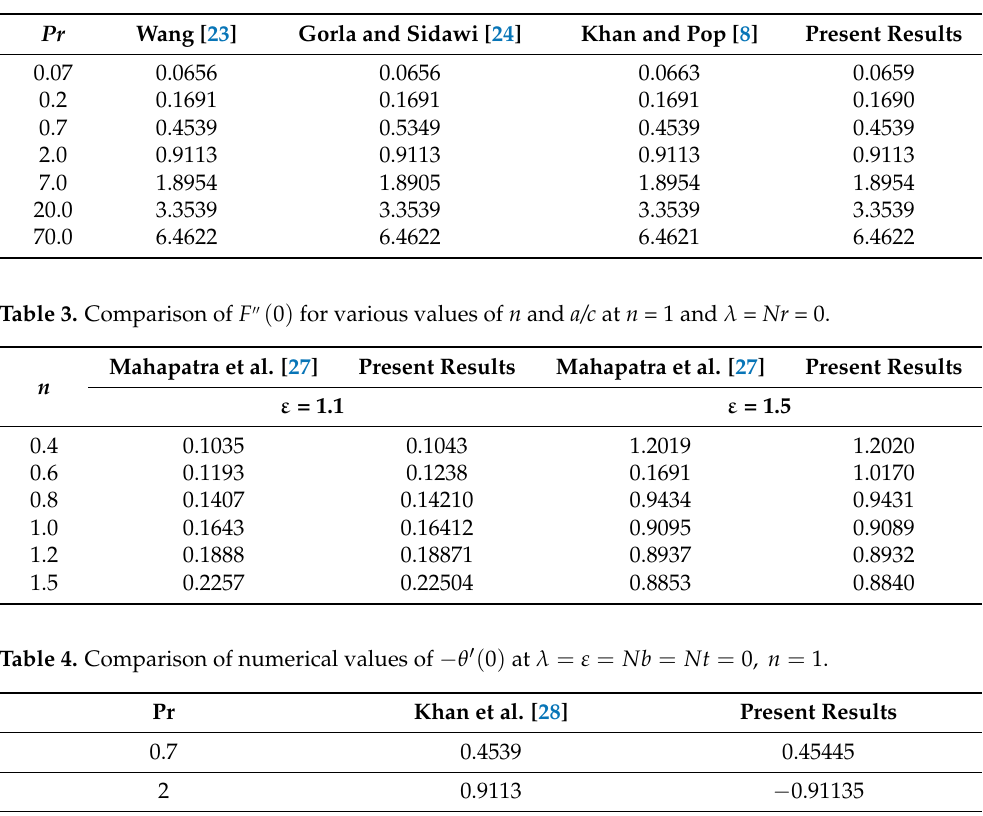
Table 2. Comparison of F (cid:48)(cid:48) ( 0 ) for various values of Pr at n = 1 and λ = Nr = 0.